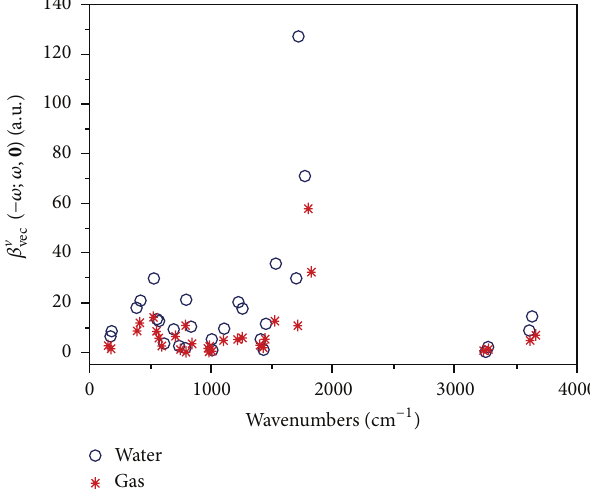
Figure 3: Frequency-dependent electronic first-order hyperpolar- izability of uracil in gas and water solution. CAM-B3LYP/aug-cc- pVDZ results. The reported data refer to the 𝛽 𝑒 vec (−𝜔 𝜎 ; 𝜔 1 , 𝜔 2 ) values obtained at ℏ𝜔 = 0.06563 a.u.